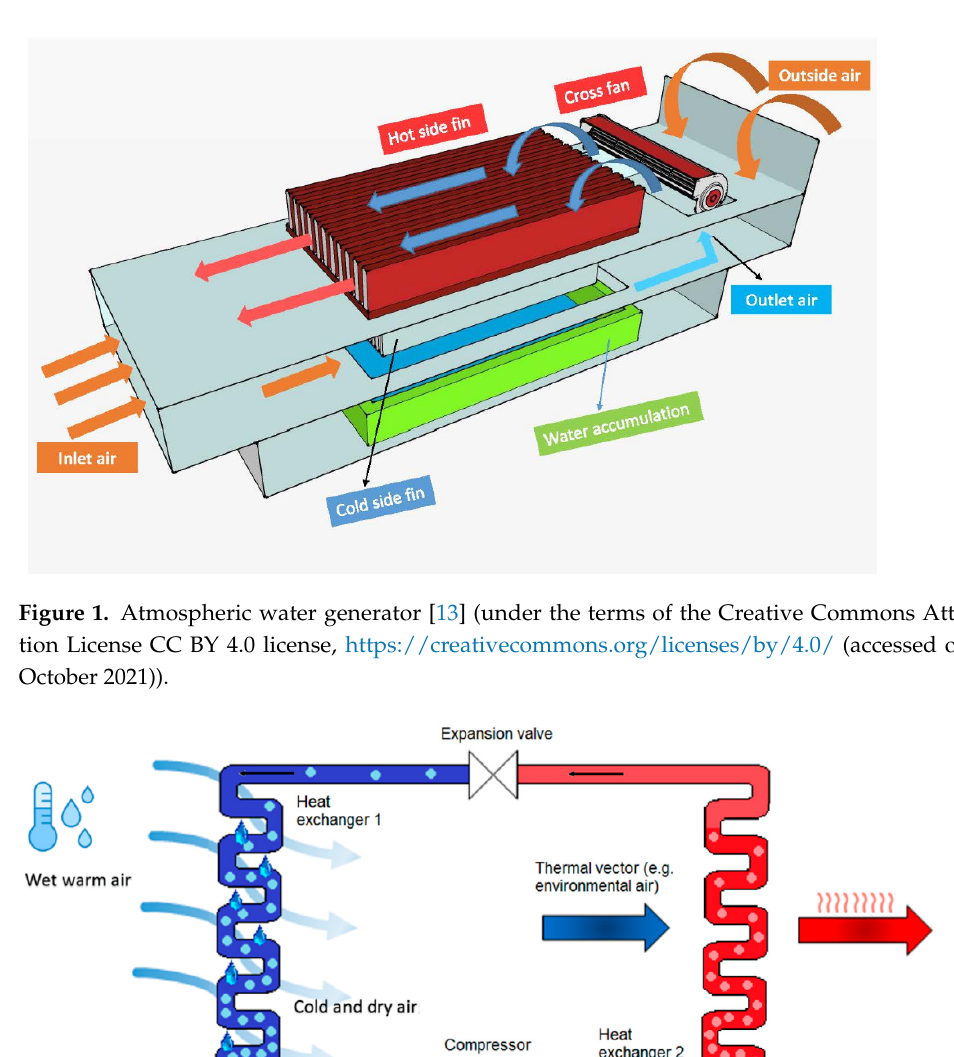
Figure 2. Reverse thermodynamic cycle [12] (under the terms of the Creative Commons Attribution License CC BY 4.0 license, https://creativecommons.org/licenses/by/4.0/ (accessed on 25 October 2021)).